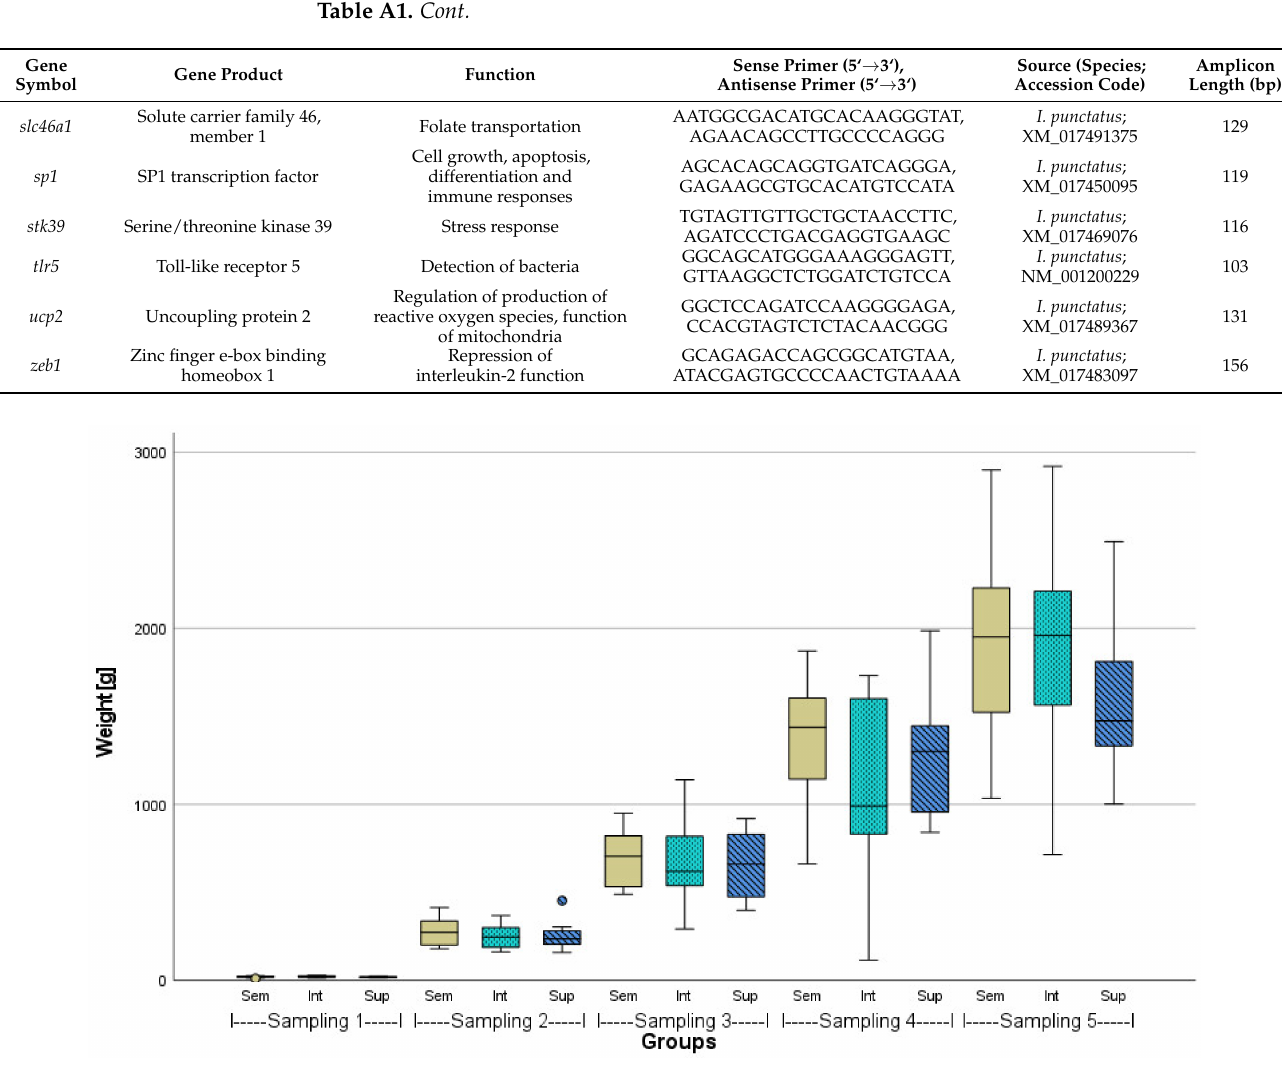
Figure A1. Weight gain of African catfish from three different stocking densities (Sem = semi-intensive, Int = intensive, Sup = super-intensive) over 23 weeks, n = 18, p > 0.05 in respective samplings. Circlet = outlier. Table A2. Cortisol: Relevant significances within a single sampling between unstressed and stressed fish in a treatment group, and between unstressed or stressed fish in a treatment group between different samplings. Sem = semi-intensive; Int = intensive; Sup = super-intensive; the number before the stocking density abbreviation indicates the respective sampling; u = unstressed, s =